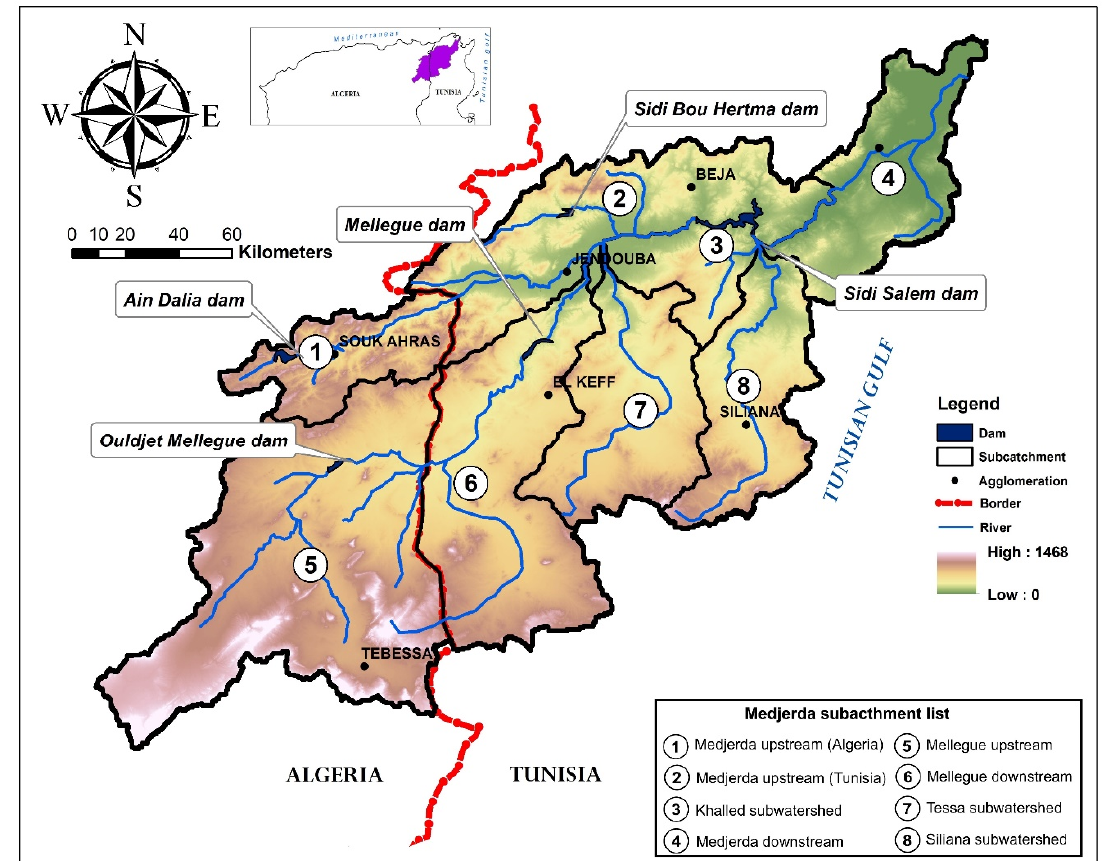
Figure 1. Location map of the study basin.